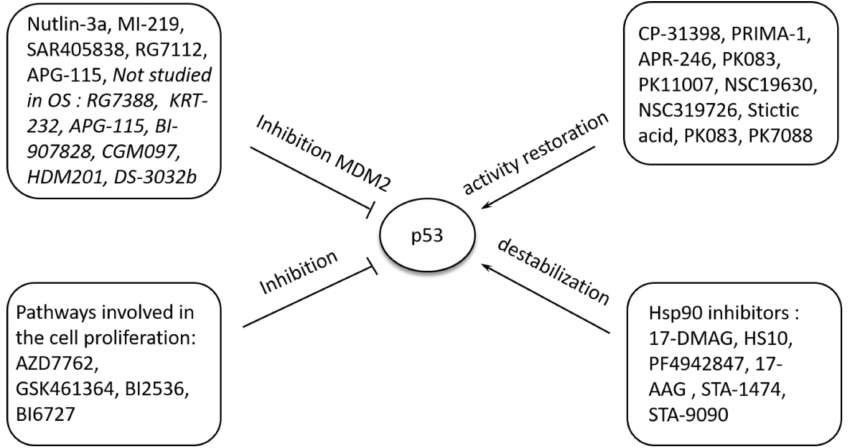
Figure 3. The main targets for pharmacological p53 modulation and selected molecules targeting p53-dependent